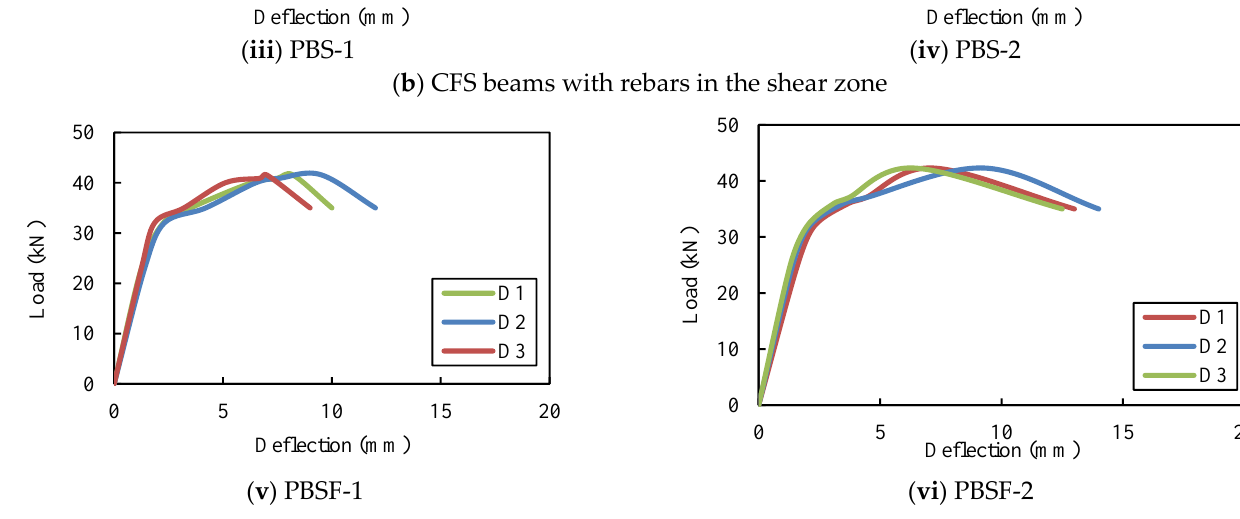
Figure 6. Load versus deflections of the plain CFS beams.